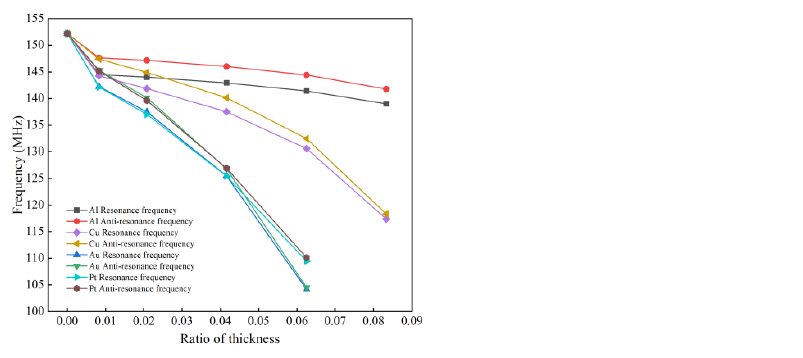
Figure 5. Variation characteristics of thickness ratio ‐ frequency under different electrode materials.